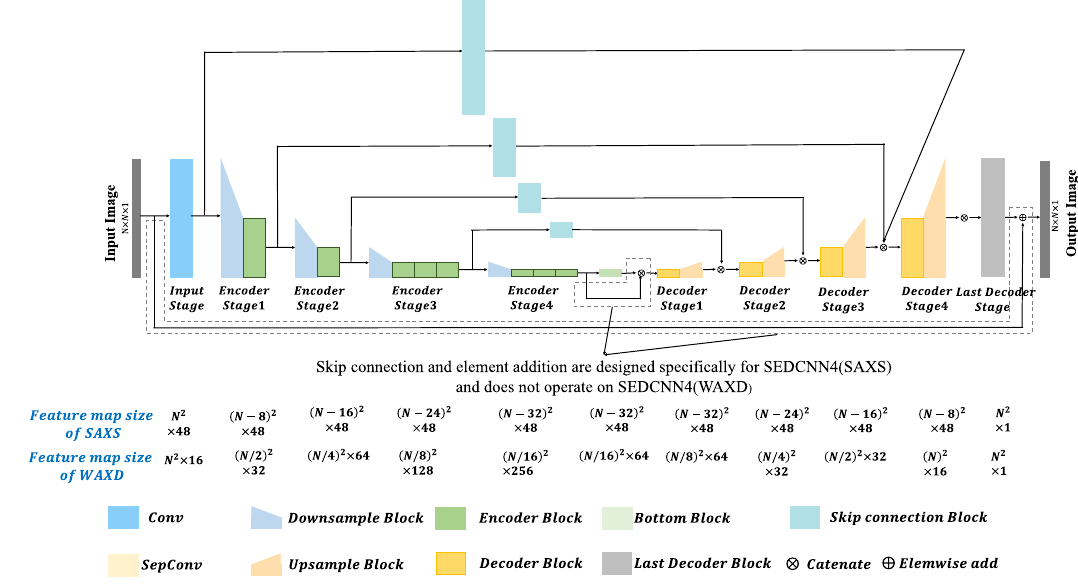
Fig. 1 Overview of SEDCNN ’ s network architecture. SEDCNN containing four stages with feature map catenations within encoder – decoder architecture, showing overall network architecture consisting of encoder and decoder stages with multiple